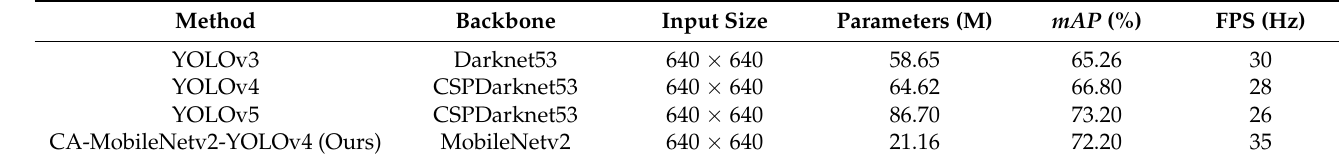
Figure 12. The visualization of vehicle – pedestrian detection results on BD100K and Ours. ( a ) Are the detection results of the original YOLOv4, ( b ) are the detection results of the improved YOLOv4 (Model 4). Table 3. Comparison results of other algorithms on KITTI